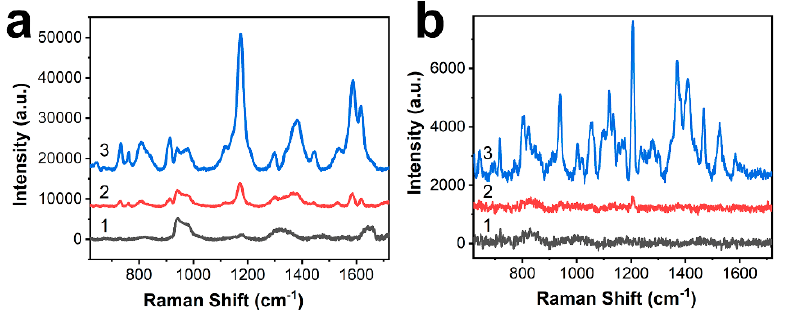
Figure 2. Surface-enhanced Raman scattering (SERS) spectra of crystal violet (CV) (10 µ M, ( a ) and IR-780 (1 µ M)), ( b ) under 785 nm excitation. The spectral lines represented the normal Raman spectra of the two dyes at the concentration of 1 mM (1), the SERS spectra induced by citrate-stabilized AuNPs (2), and the SERS spectra induced by BP-AuNSs (3), respectively.